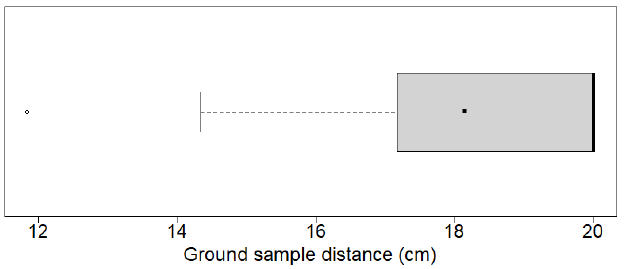
Figure 3. Ground sample distance of the aerial images of the 36 sample blowdown areas.